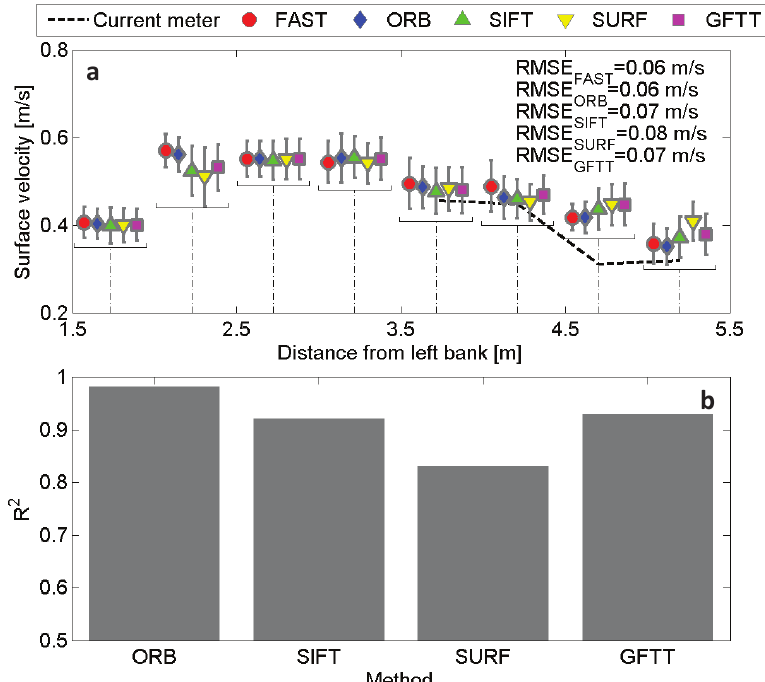
Figure 4. ( a ) Time-averaged surface flow velocity cross-sectional profiles obtained by processing the 12 image sequences on the Brenta River with OTV. Error bars indicate standard deviations. The black dashed line illustrates average velocities obtained with the current meter. Root mean square error (RMSE) values between OTV results and the current meter data are reported. OTV data obtained from different feature detectors refer to consistent distances from the left stream bank as indicated with brackets and dash-dotted lines; ( b ) R 2 values computed between results from each feature detector and the features from accelerated segment test (FAST)